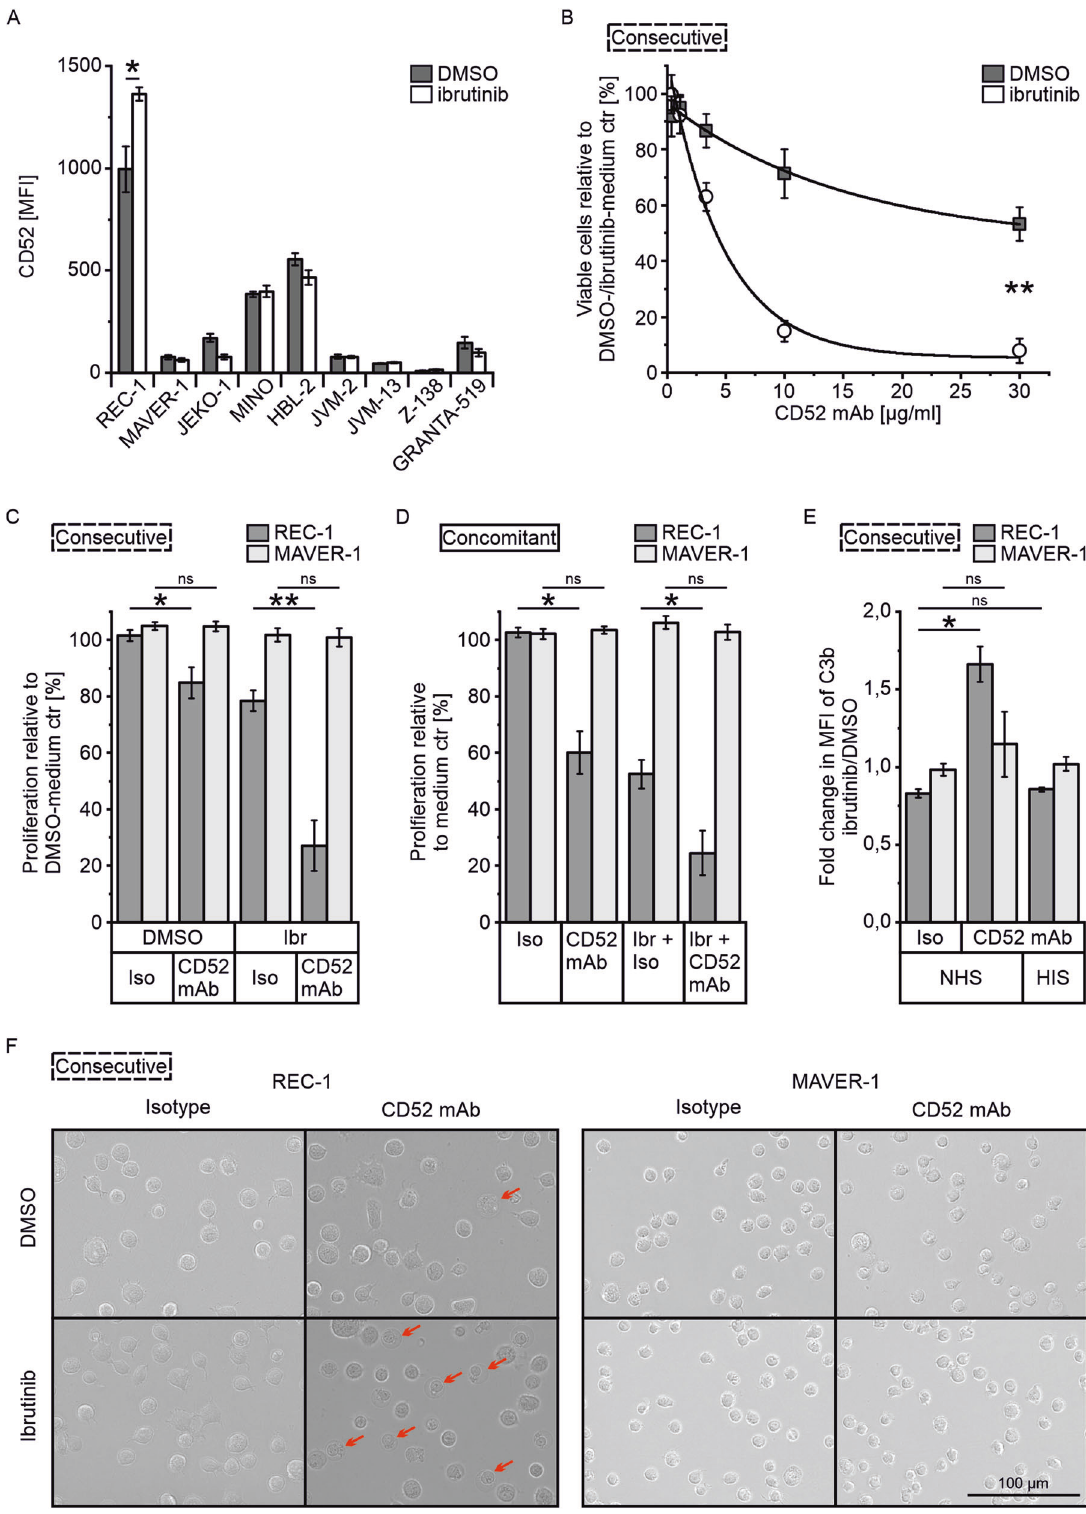
Since dead cells from pretreatment were removed and only viable REC-1 cells were tested in consecutive setup, proliferation of REC-1 cells was still 78% in ibrutinib-pretreated isotype control (Fig. 3C). Upon addition of CD52 mAb with NHS, proliferation of